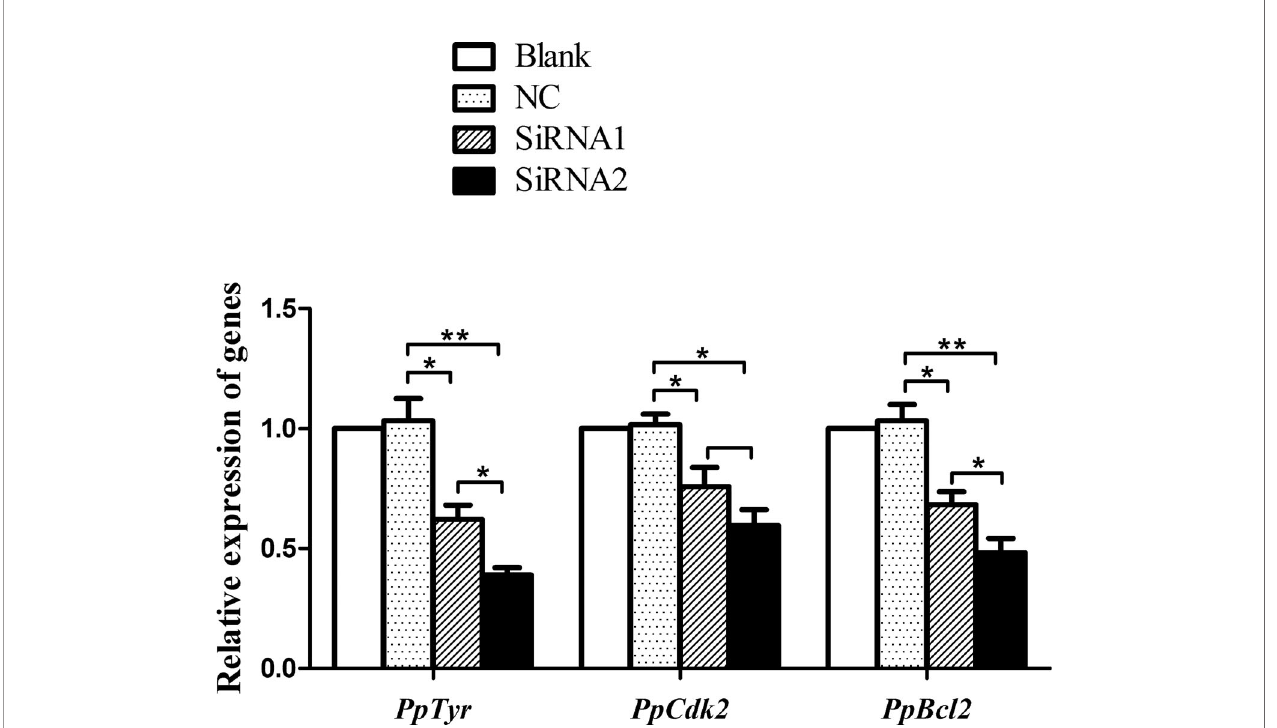
FIGURE 6 | Transcriptional levels of PpTyr , PpCdk2 and PpBcl2 after PpMitf RNAi. The qRT-PCR was performed using samples from blank, NC, siRNA1 and siRNA2 group. The abundance of mRNA was normalized to that of b -actin of P. penguin . The data were represented as the mean ± SD ( N = 5). * P < 0.05; ** P < 0.01.